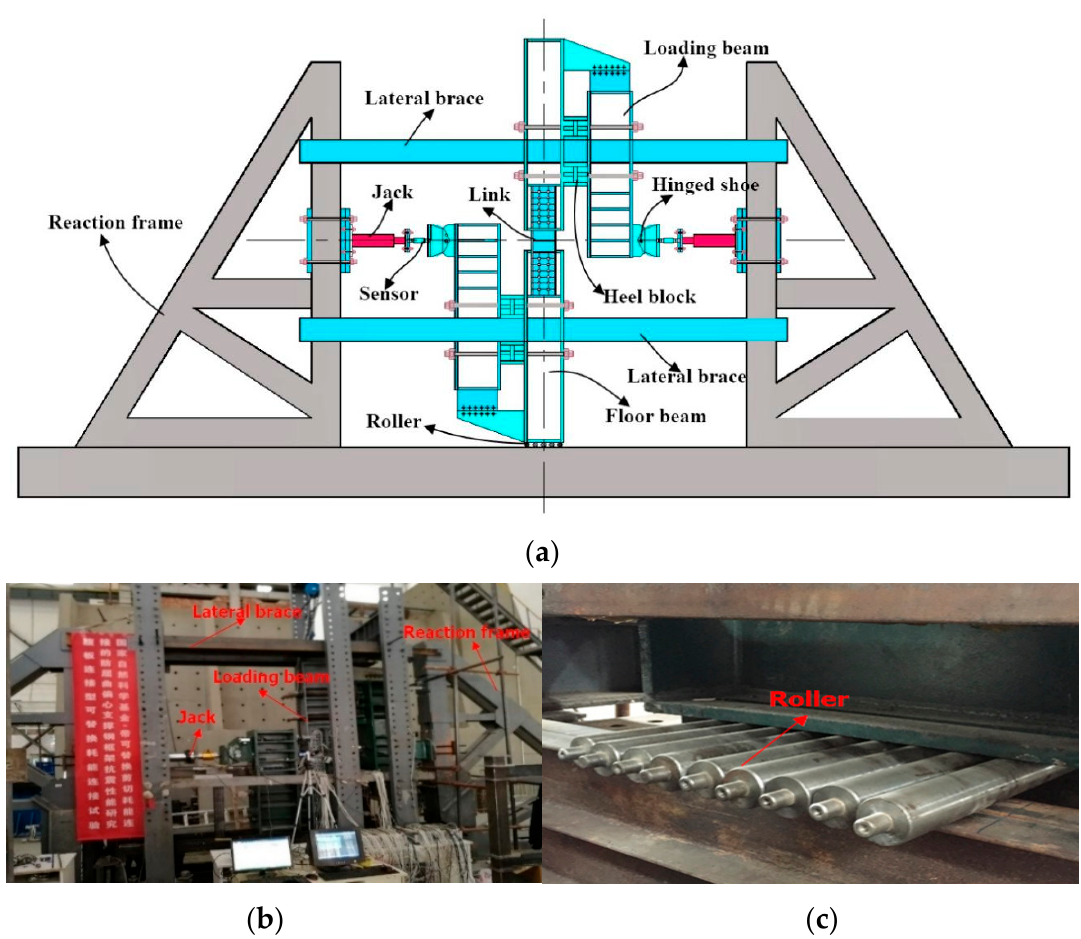
Figure 3. Experimental setup. ( a ) Details of test setup; ( b ) Photo; and, ( c ) Roller.